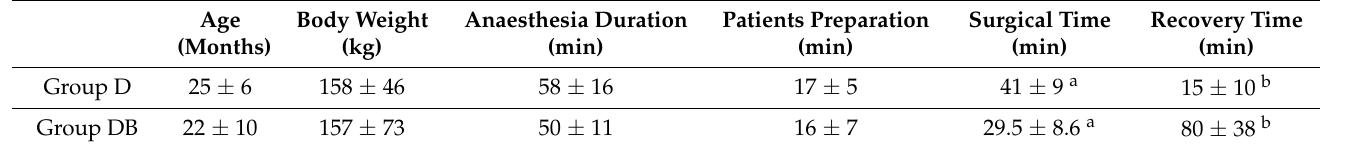
Table 1. Age, body weight, duration of anaesthesia, patient preparation, surgical time and recovery time in the two groups. Values are expressed as mean ± SD (SD: standard deviation). Statistical differences are expressed by the same letter on the same column (a: p = 0.016; b: p =